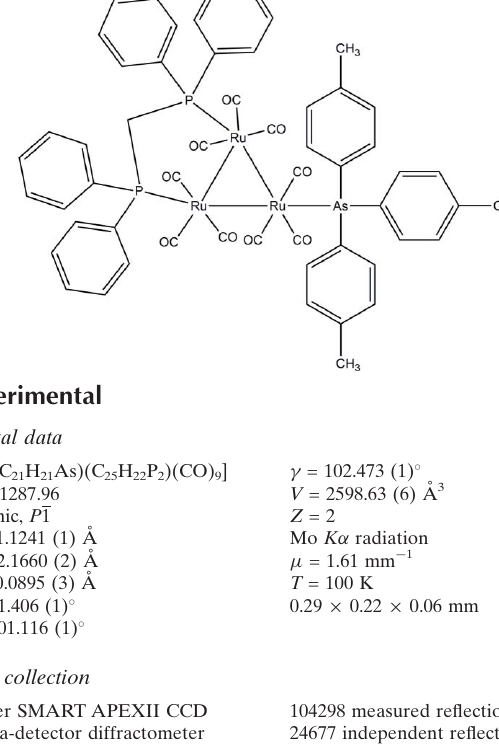
Data collection Bruker SMART APEXII CCD area-detector diffractometer Absorption correction: multi-scan ( SADABS ; Bruker, 2005)